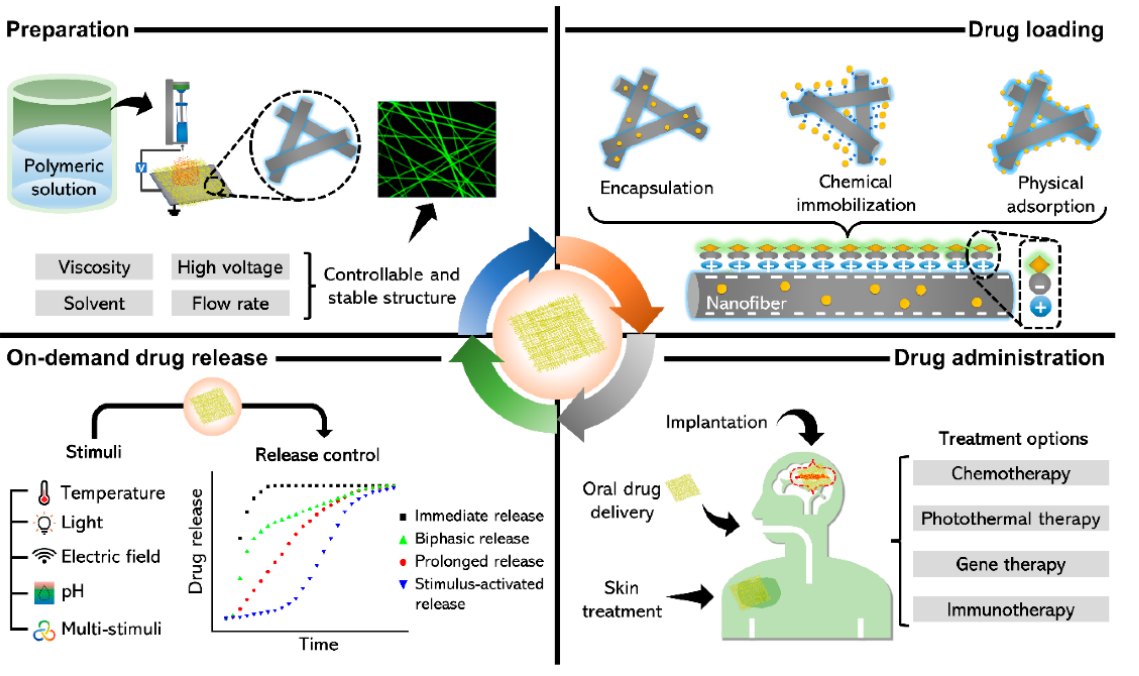
Figure 8. Overview showing the use of nanofiber mats in drug delivery. From [218], originally published under a CC-BY license.